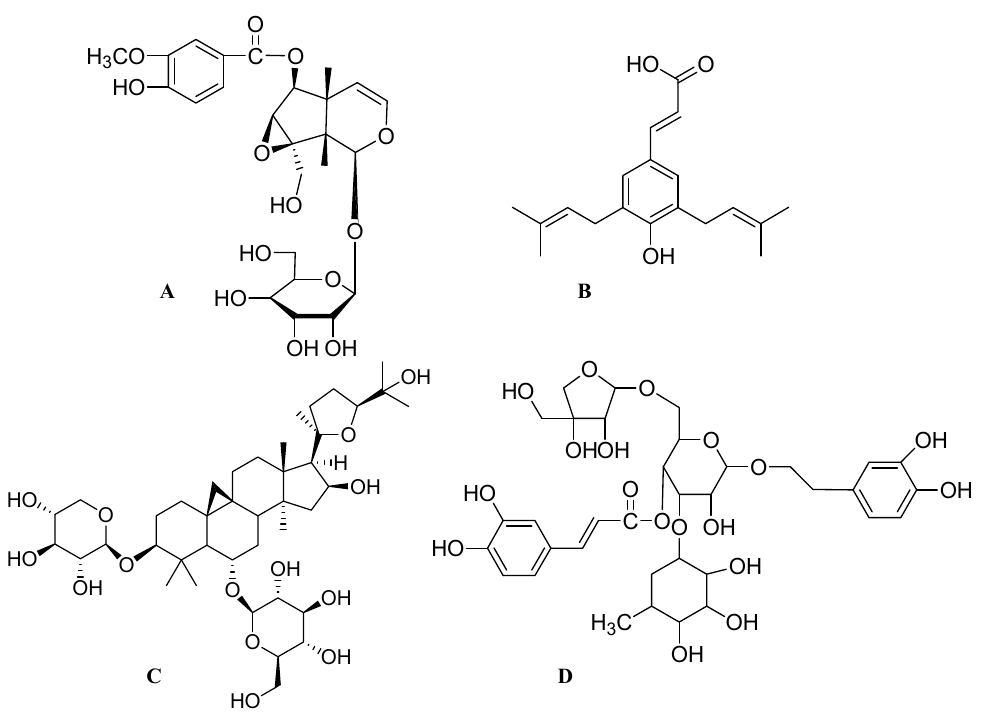
Figure 3. The molecular structures of picroside II ( A ), artepillin C ( B ), astragaloside IV ( C ) and pedicularioside A ( D